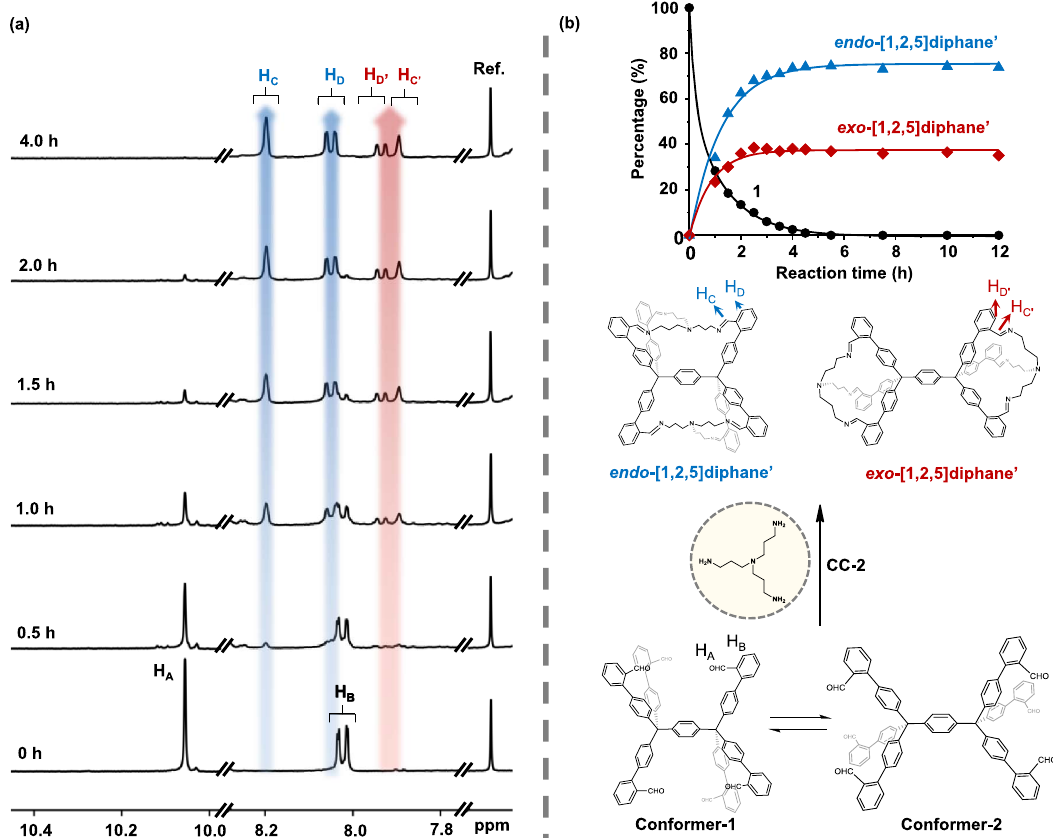
Fig. 6 1 H NMR study of the conformer capturing the progress of Conformer-1 and -2 with large-sized CC-2 as a function of time. a The 1 H NMR spectra indicate that Conformer-1 and -2 are captured simultaneously with CC-2. b The evolution pro fi le of molecule 1 in gray, endo -[1,2,5]diphane ’ in blue and exo - [1,2,5]diphane ’ in red, determined by the ratios of integral areas of the corresponding characteristic peaks with the internal reference peak of dioxane. H A represents the proton of aldehyde group of molecule 1 , H B the nearest proton to H A ; H C the proton of schiff base of endo -[1,2,5]diphane ’ , H D the nearest proton to H C on the rigid part of the molecule; H C ’ and H D ’ the corresponding protons of exo -[1,2,5]diphane ’